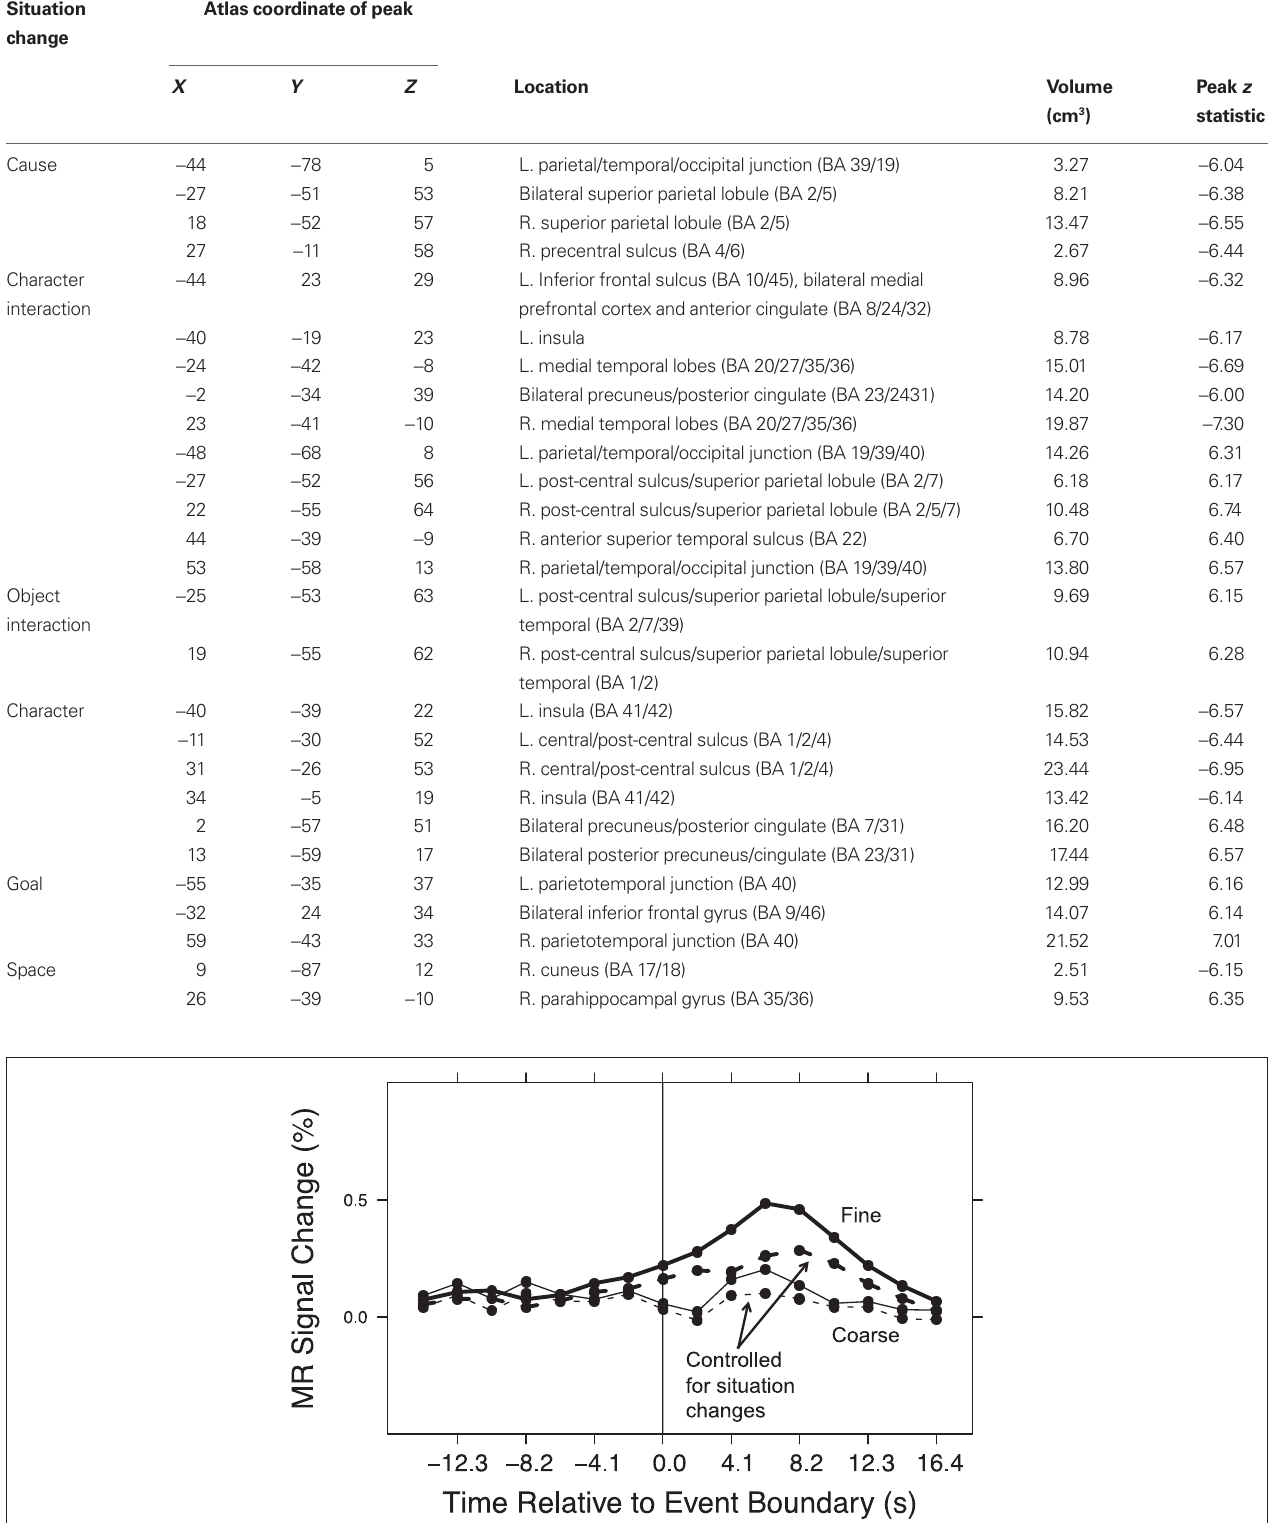
Table 4 | Regions of significant transient fMRI change at situation changes.